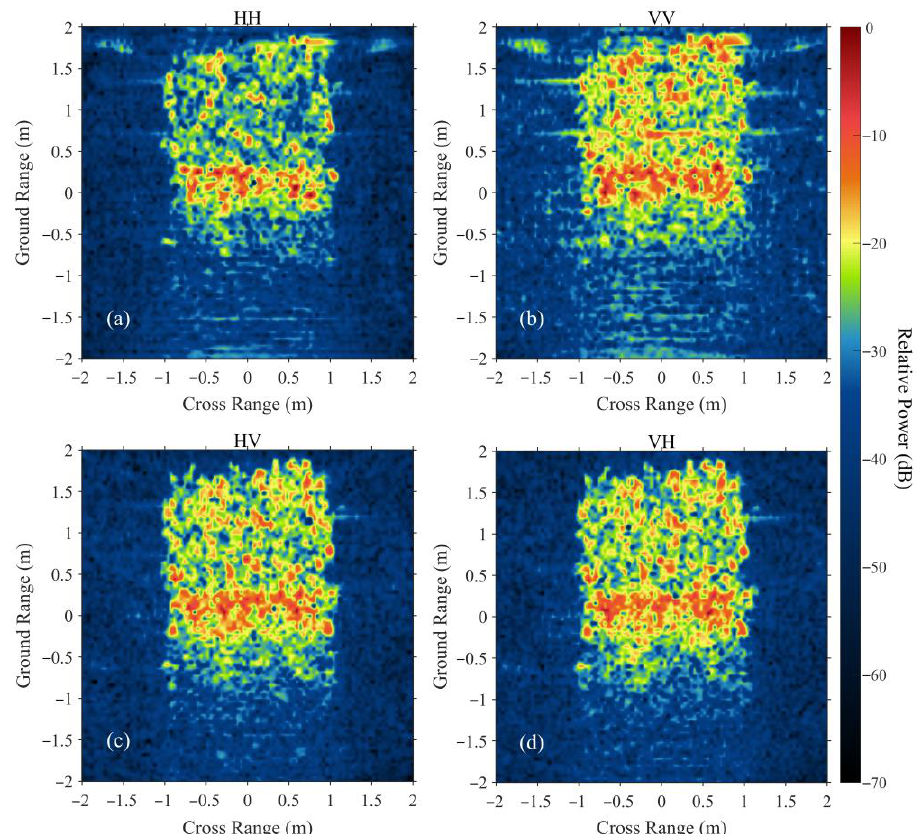
Figure 17. Full-polarization SAR imaging results of rice field Scene 1 at the Ku band and an incidence angle of 40° for ( a ) HH, ( b ) VV, ( c ) HV, and ( d ) VH polarizations.